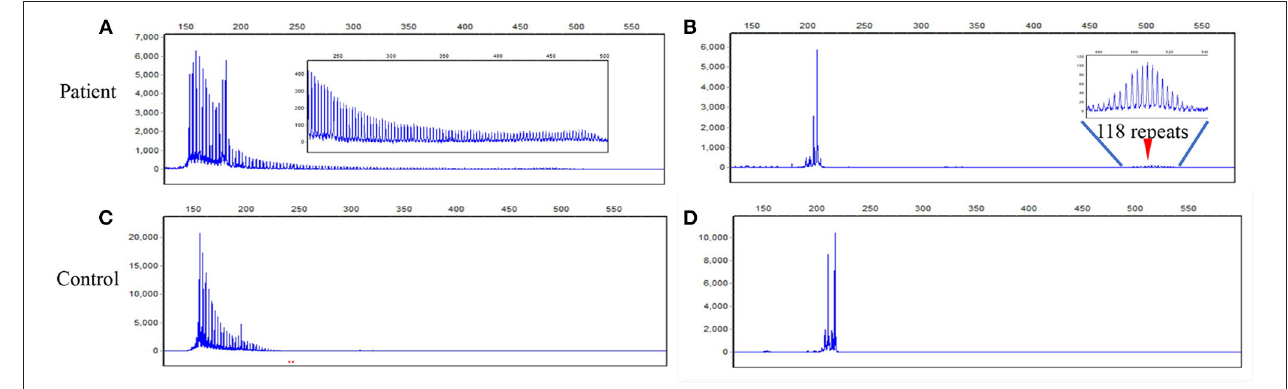
FIGURE 2 | RP-PCR and fluorescence AL-PCR in the patient and a negative control. (A) RP-PCR showed a characteristic saw-tooth pattern in the patient. (B) Fluorescence AL-PCR showed expanded allele had an unusual peak at around 507 bp (arrowheads) in the patient. The GGC repeat number of expanded allele was calculated according to the length of the highest fluorescent peak in expanded alleles [GGC repeat number = (507–154)/3]. (C) RP-PCR showed only single peak wave without a saw-tooth pattern in a negative control. (D) Fluorescence AL-PCR showed no repeat expansion in a negative control. RP-PCR, repeat-primed PCR; AL-PCR, amplicon length PCR.